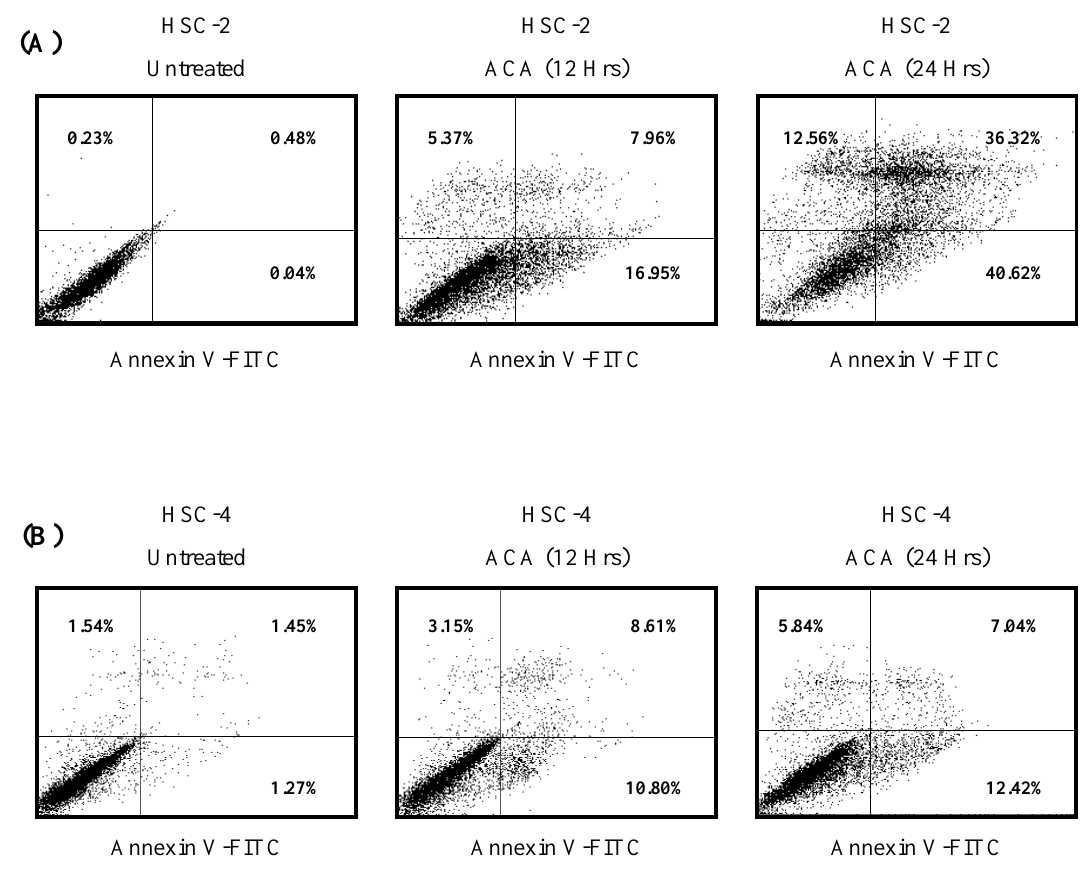
Figure 5. Detection of apoptosis using flow cytometry after annexin V-FITC/ propidium iodide (PI) staining indicating that ACA potentiates apoptosis-mediated cell death after 12 hrs and 24 hrs of exposure. (A) HSC-2 cells treated with ACA; (B) HSC-4 cells treated with ACA. Viable cells are in the lower left quadrant, early apoptotic cells are in the lower right quadrant, late apoptotic cells are in the upper right quadrant and non-viable necrotic cells are in the upper left quadrant. Dot plots are a representative of 10,000 cells from a single